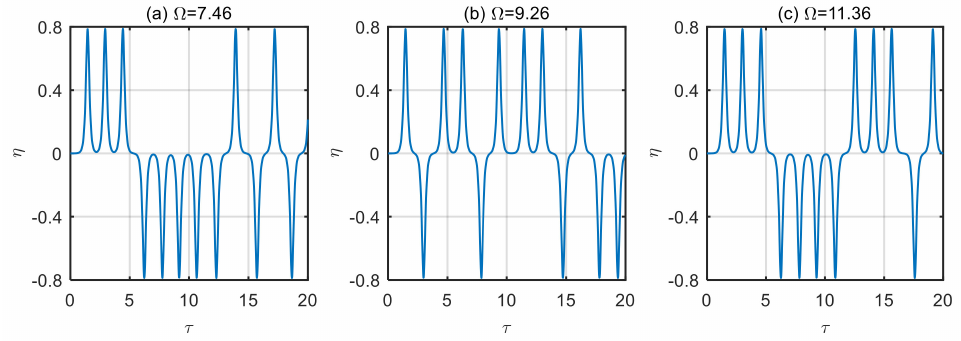
Figure 11. Displacement time history diagram of microtubes with different dimensionless frequencies of excitation loads ( u = 6). ( a ) Ω = 7.46; ( b ) Ω = 9.26; ( c ) Ω = 11.36.